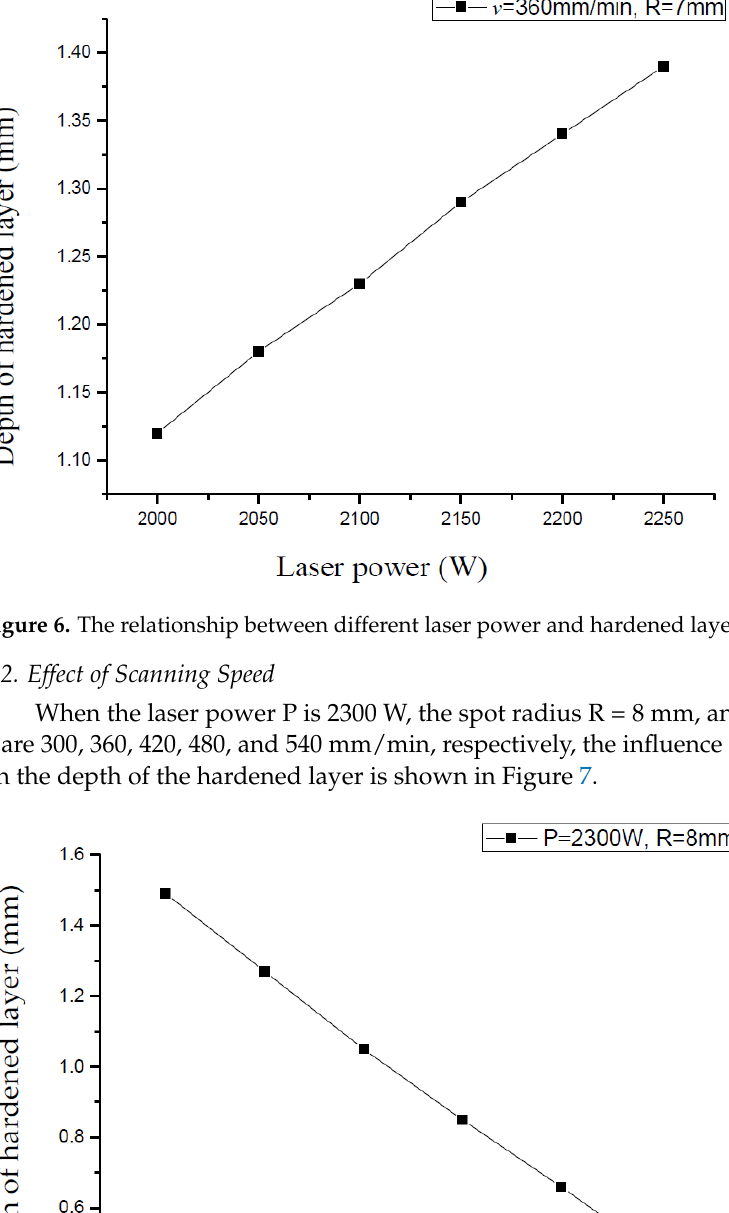
Figure 7. The relationship between different scanning speed and hardened layer depth.